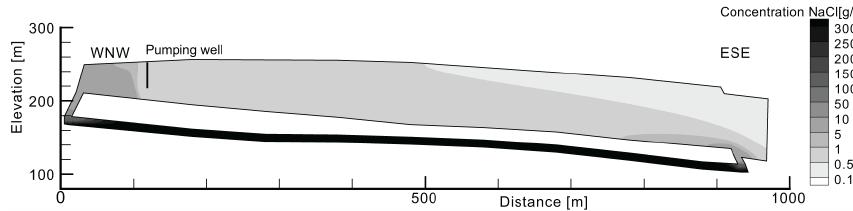
Figure 5. NaCl concentration distribution over the domain after 3years of simulation with 10m fault thickness.